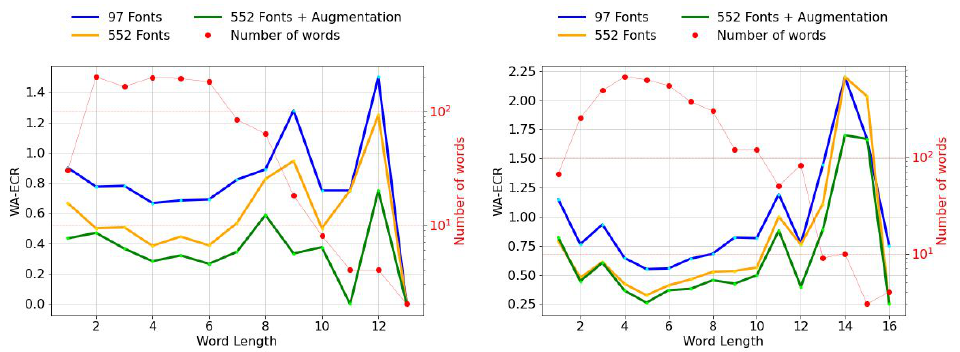
Figure 10. WA-ECR of our Hindi models tested on IIIT-ILST ( left ) and MLT-19 ( right ) datasets.